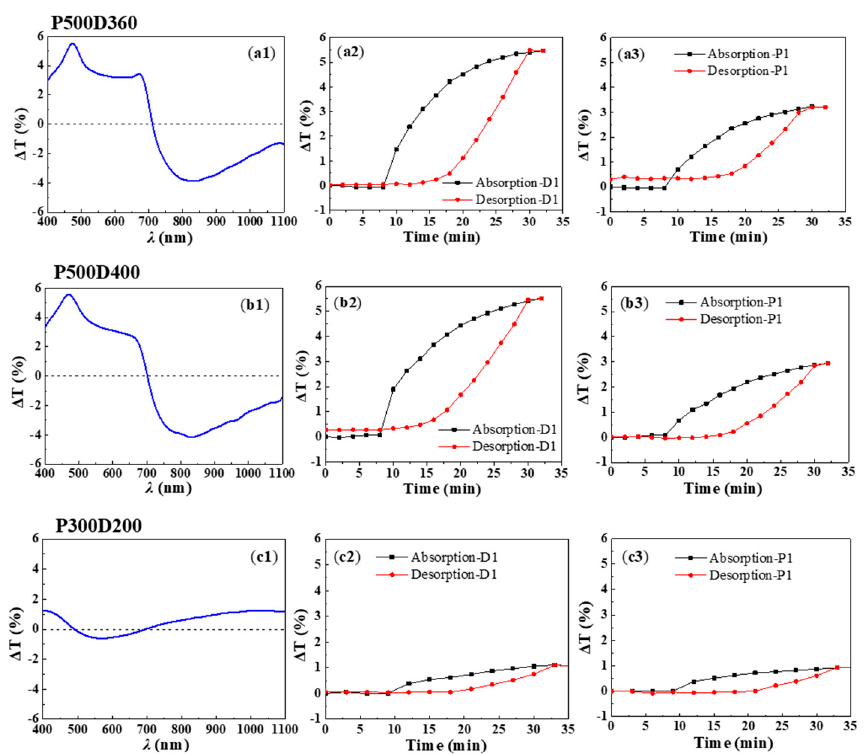
Figure 3. Spectral transmittance changes for different Pd NHAs: ( a1 – a3 ) P500D360; ( b1 – b3